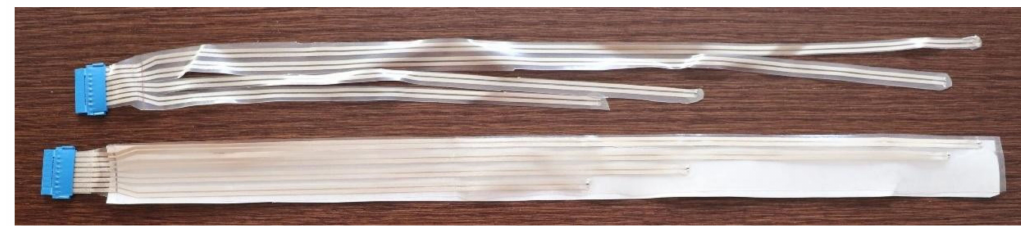
Figure A6. Final prototype. On the bottom, a complete multisensor; and on the top, a multisensor divided by sensors to facilitate its